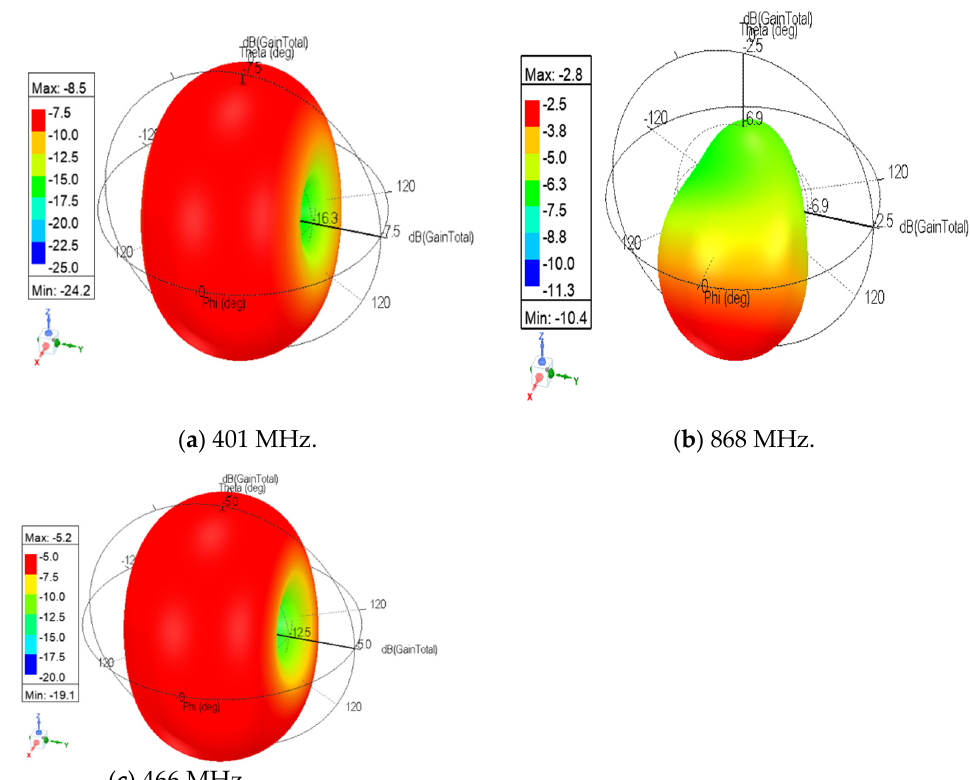
Figure 10. Simulated radiation patterns: ( a ) at 401 MHz (OFF state); ( b ) at 868 MHz (OFF state); ( c ) at 466 MHz (ON state).